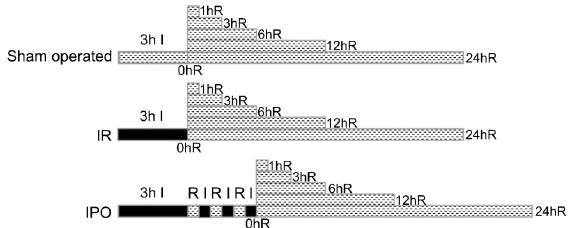
Figure 1. Experimental protocol used to determine the effect of one possible variation in ischemic postconditioning (IPO) on skeletal muscle after ischemia (I) and reperfusion (R). In the sham-operated group (n=36), there was no intervention; ische- mia-reperfusion (IR, n=36) consisted of 3 h of I followed by 0, 1, 3, 6, 12, or 24 h of R; IPO (n=36) consisted of 3 h of I followed by 3 cycles of 30 s of R and 30 s of I, and then followed by 0, 1, 3, 6, 12, or 24 h of R,